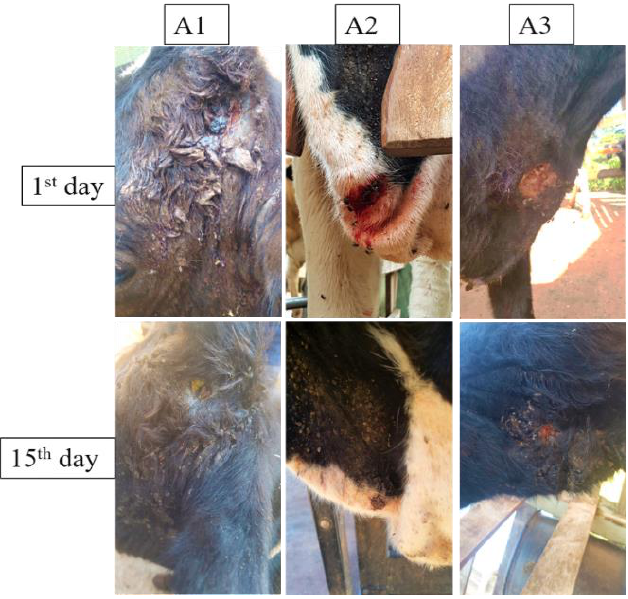
Figure 6. Monitoring photographs of animals treated (A1 – A3) with CrD-Ore. The pictures show deep lesions in the head region (horn removal wound in cattle — A1) and chest (accidental lesions — A2 and A3).